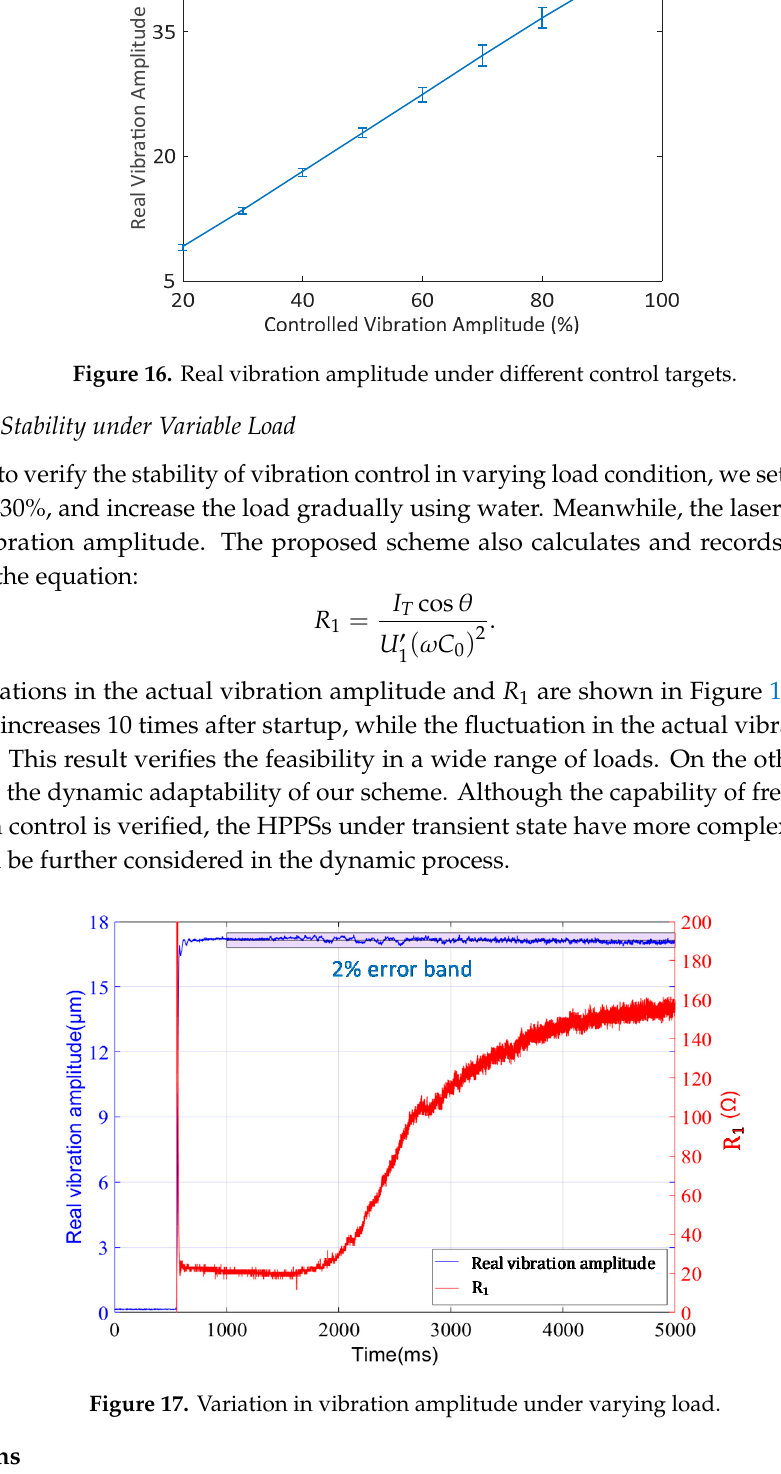
Figure 15. Experimental setup of vibration control verification.